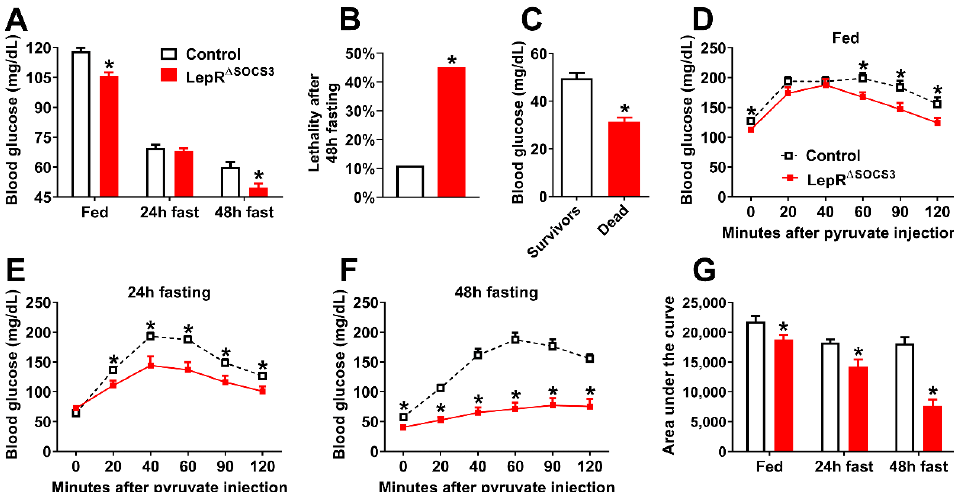
Figure 9. LepR ∆ SOCS3 mice exhibit fasting-induced hypoglycemia that is associated with reduced gluconeogenesis. ( A ) Blood glucose concentrations at the fed state or after 24 h or 48 h fasting in young adult control ( n = 40) and LepR ∆ SOCS3 ( n = 32) mice. ( B ) Percentage of mice that died after a 48 h fasting period in control and LepR ∆ SOCS3 mice. ( C ) Blood glucose concentrations in mice that died ( n = 20) or survived ( n = 27) the 48 h fasting period (including the refeeding period). ( D – F ) Blood glucose concentrations during pyruvate tolerance tests in young adult control ( n = 20–21) and LepR ∆ SOCS3 ( n = 8–11) mice at the fed state or during 24 h or 48 h fasting. ( G ) Area under the curve of the pyruvate tolerance tests in control and LepR ∆ SOCS3 mice at the fed state or during 24 h or 48 h fasting. Mean ± SEM. * p < 0.05 control vs. LepR ∆ SOCS3 (post-hoc test two-way ANOVA or t - test).